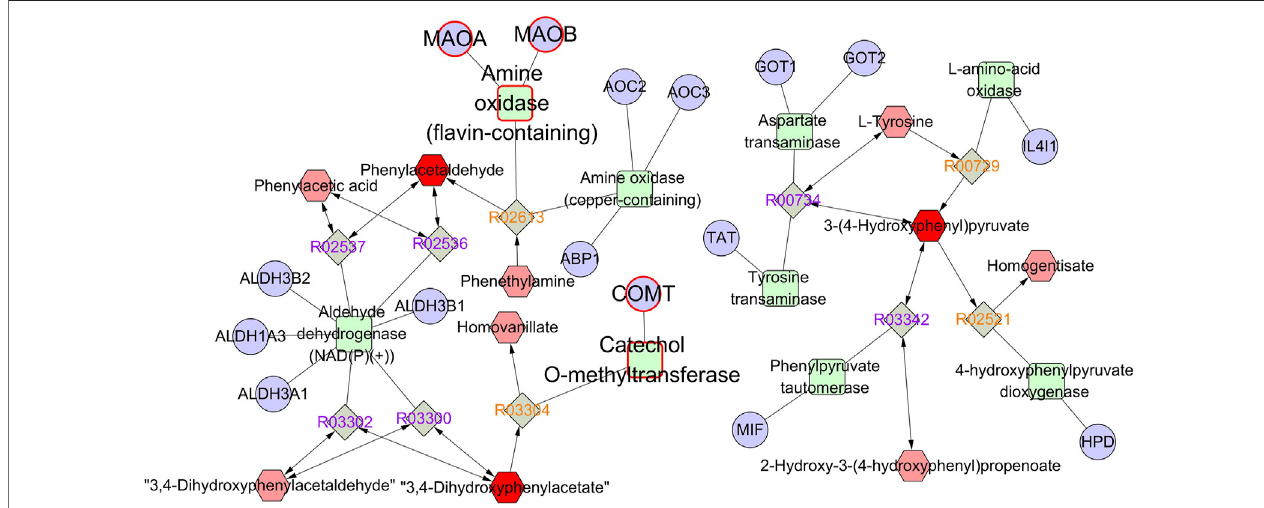
FIGURE 7 | The compound – reaction – enzyme – gene network of tyrosine metabolism. The red hexagons, gray diamonds, green round rectangles, and purple circles represent active compounds, reactions, proteins, and genes, respectively.